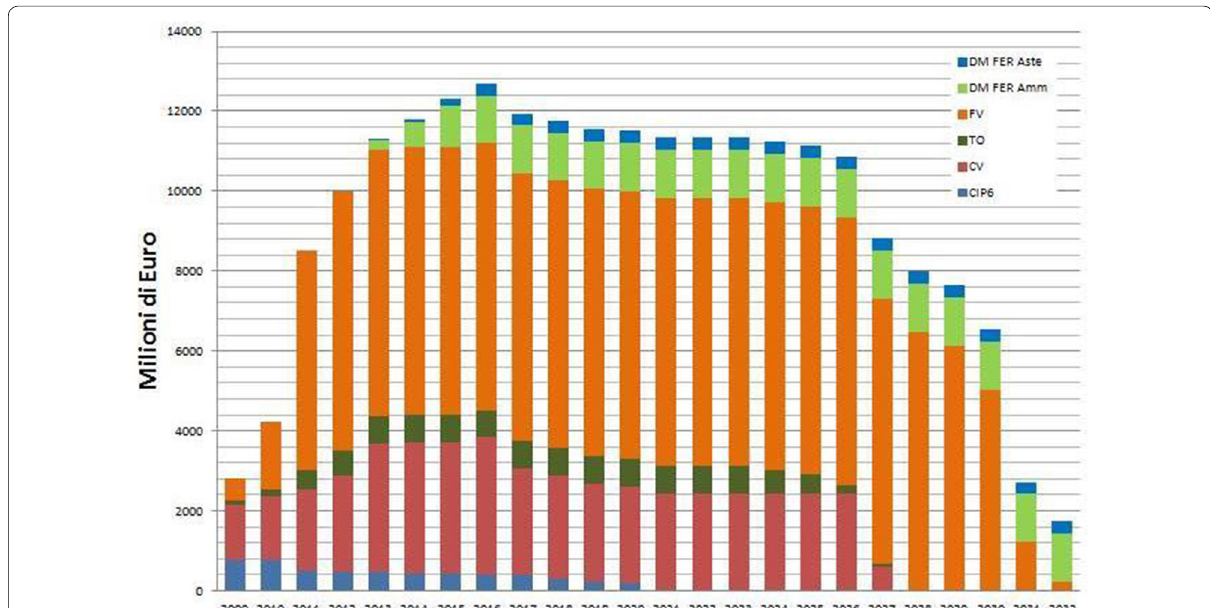
Fig. 1 Cost of support mechanisms for RES (Source: Assoelettrica on data from the energy services operator and the authority for electricity and